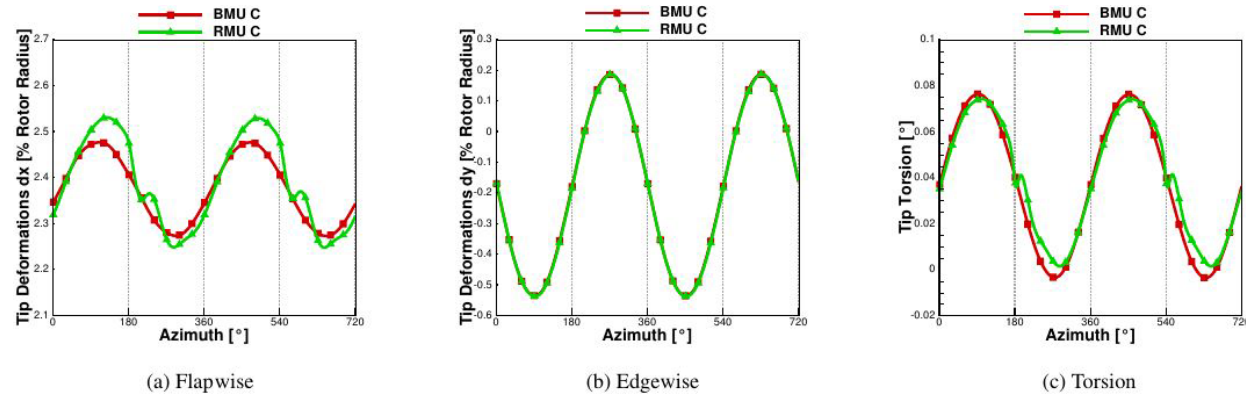
Figure 5. Tip deformations calculated with CFD at 6.1ms − 1 comparing BMU coupled (C) vs. RMU coupled (C). Out-of-plane deformation in (a) , in-plane deformation in (b) and torsion in (c) .